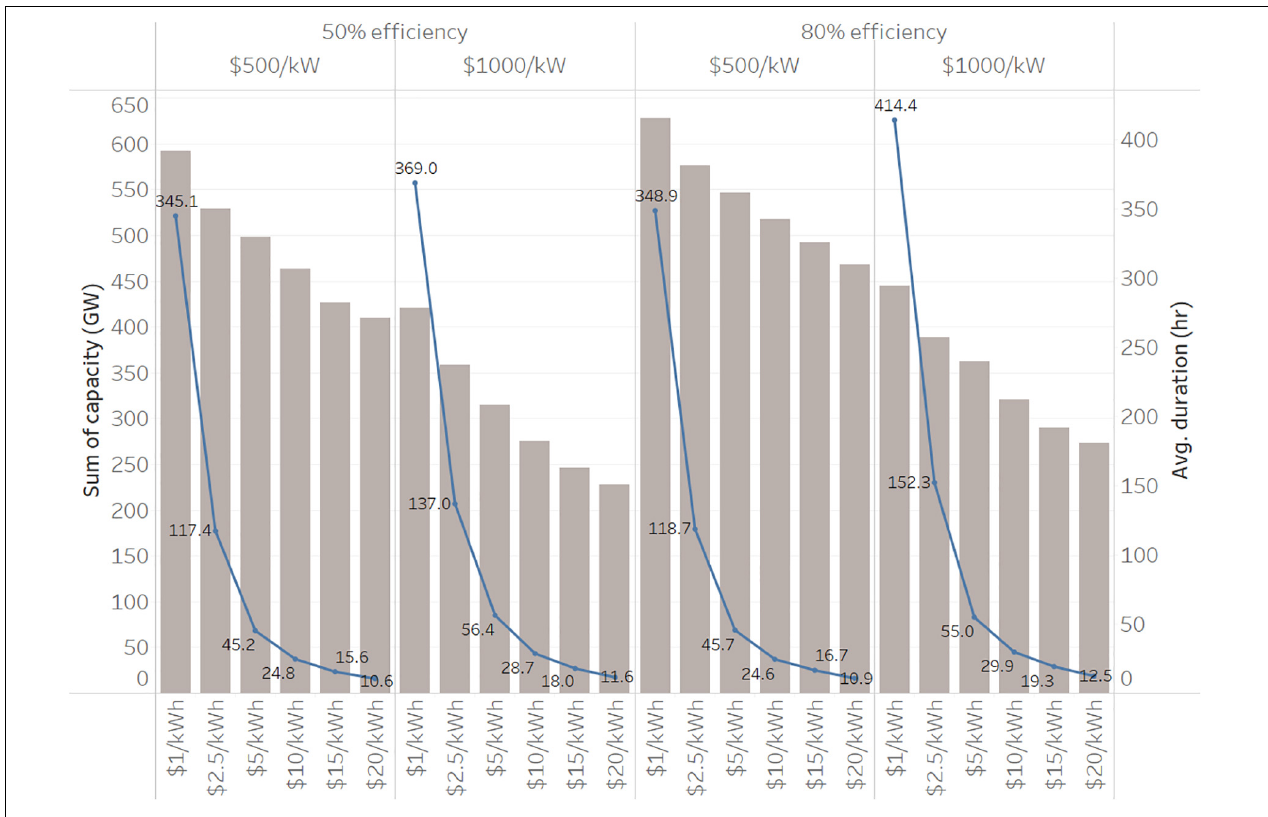
FIGURE 3 | LTS capacity and duration in 2050 at different LTS costs ( top labels: efficiency and $/kW cost, bottom labels: $/kWh